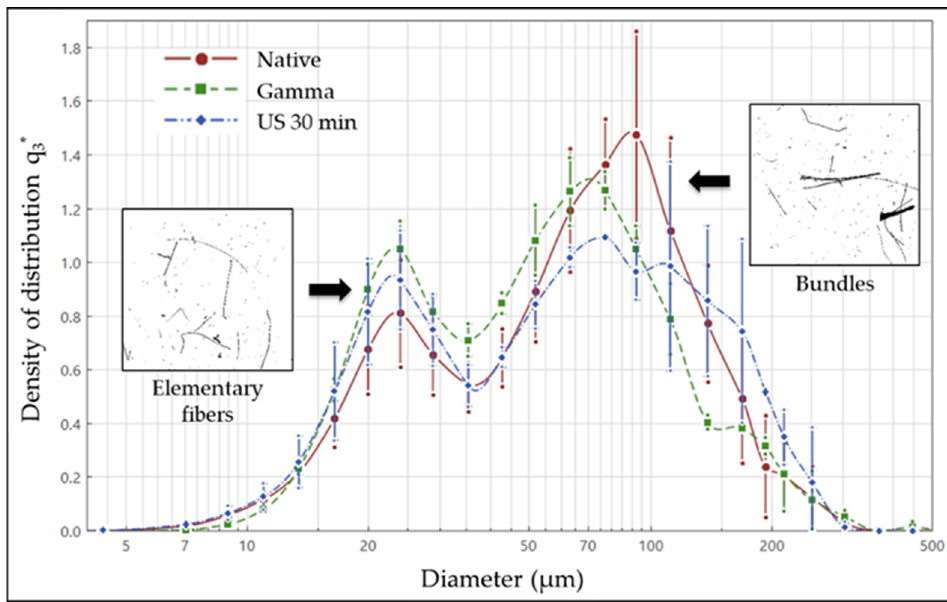
Figure 4. Diameter density of native and pre-treated flax tows and binary images of elementary fibres and fibre bundles in the two insets.